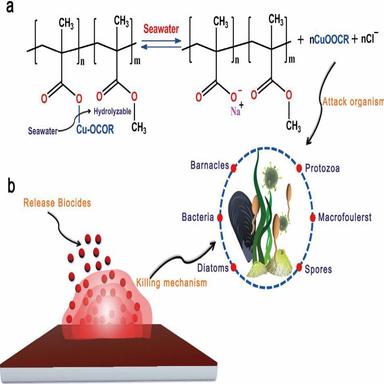
(a) Main reaction of the general chemical structure of the hydrolyzable polymethacrylic acid copolymer with seawater, (b) killing mechanism of the biocide AF coating prevents bioadhesion through its toxic effects.